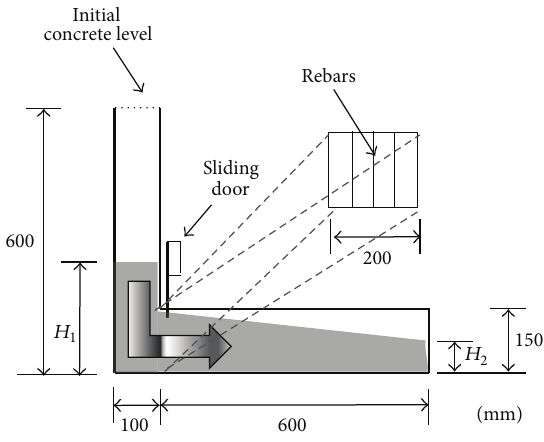
Figure 5: The configuration of the L-box test for SCC [15].